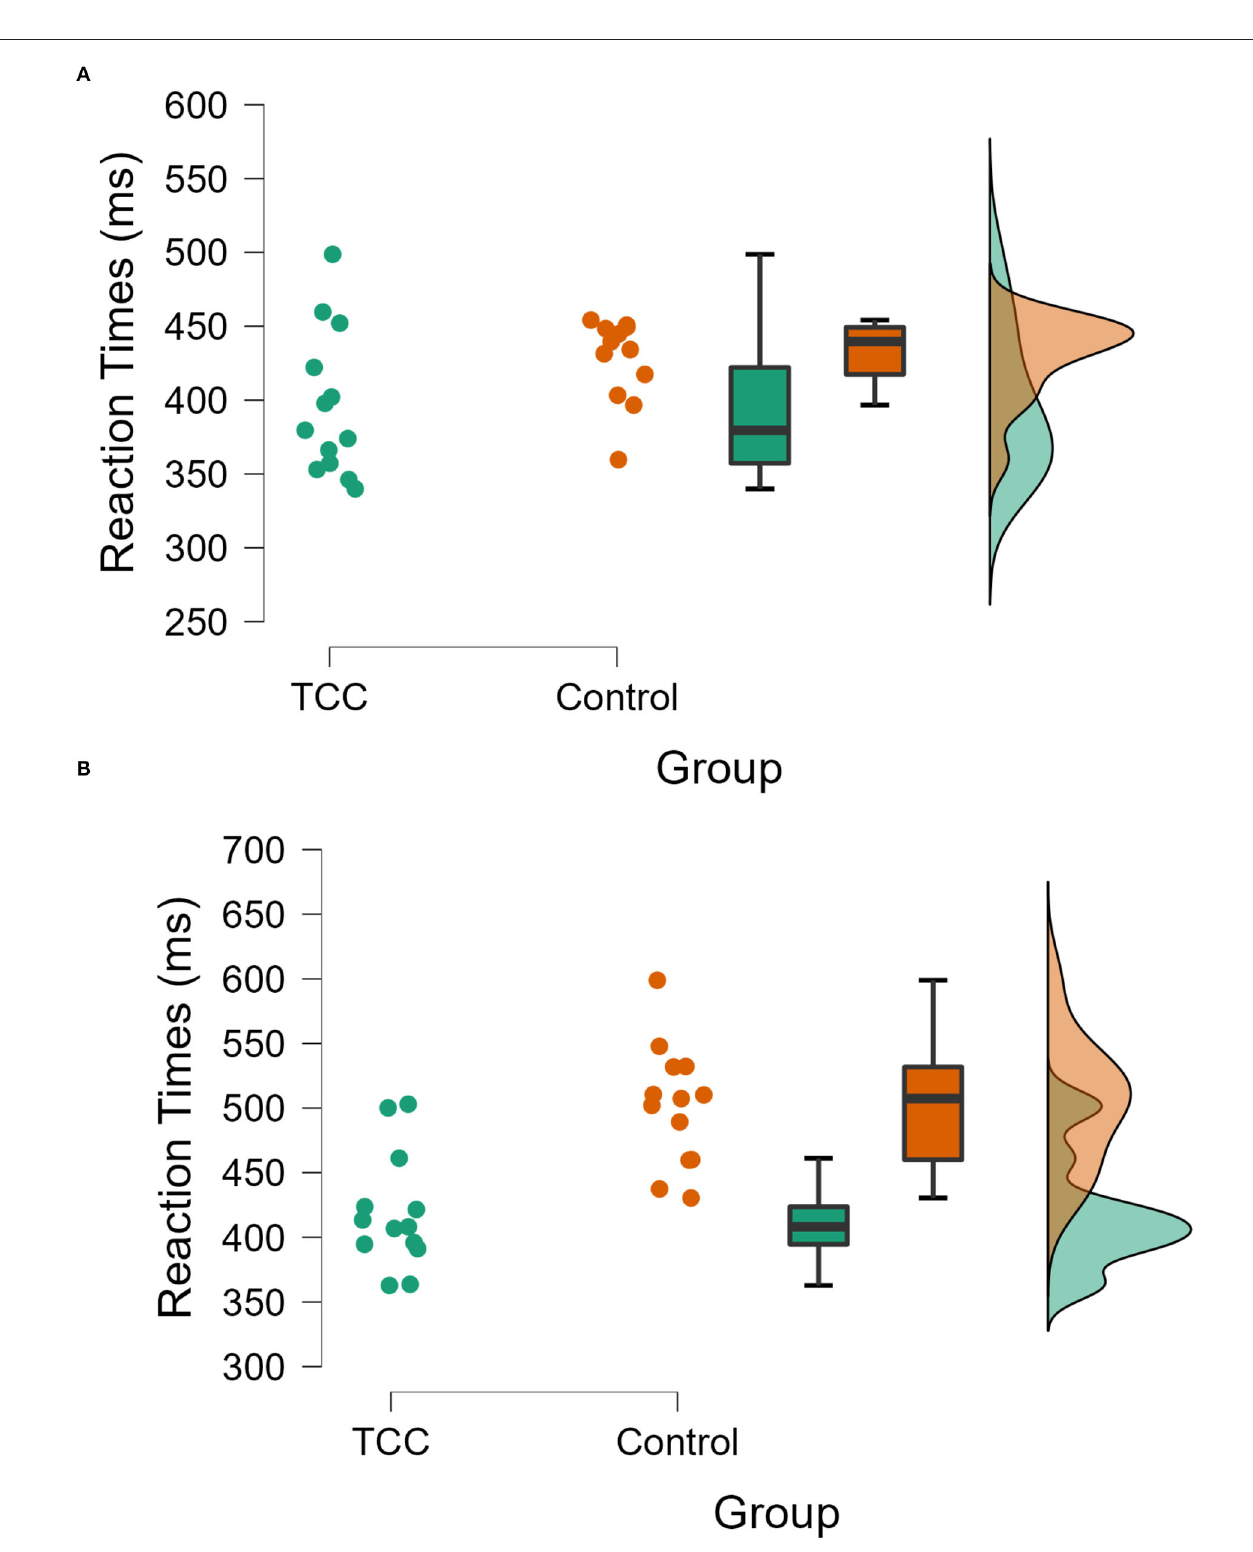
FIGURE 4 | Comparison of RTs between the two groups (TCC vs. controls) during the N-back task ( A : 1-back; B : 2-back).